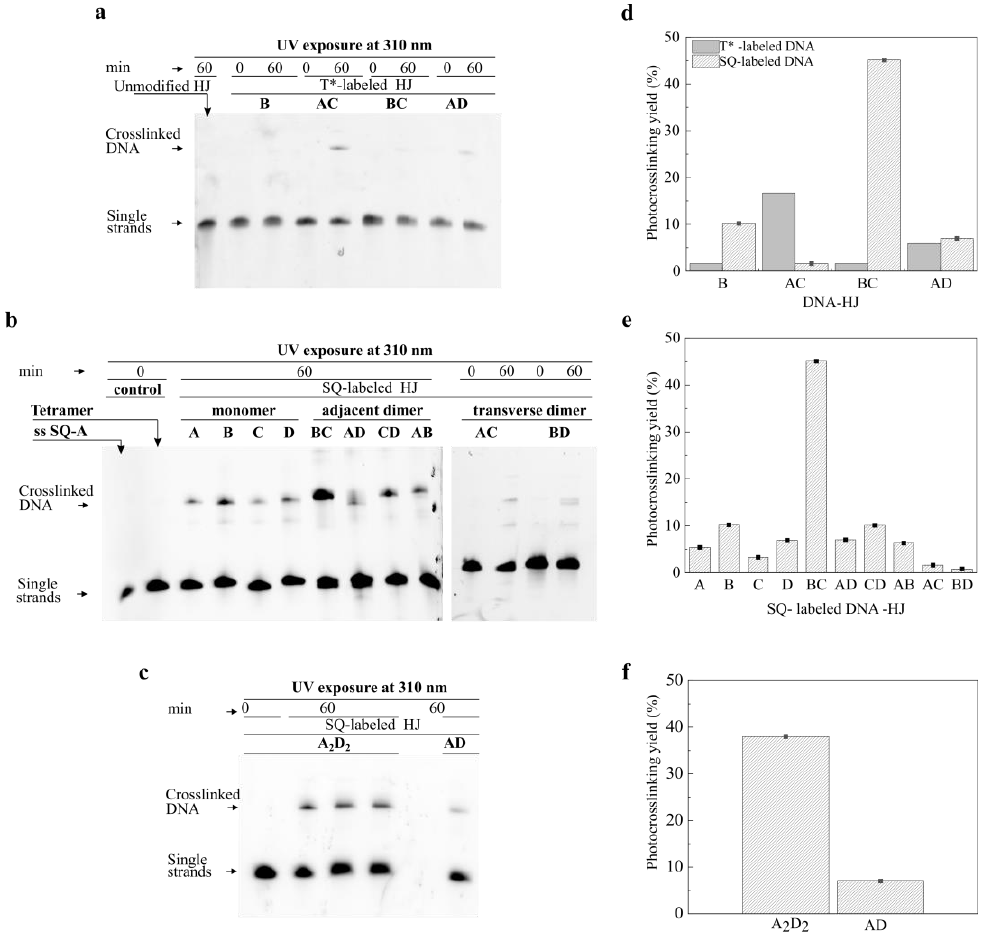
Figure 3. Electrophoretic analysis of photocrosslinking in HJ constructs. ( a – c ) Images of denaturing PAGE with samples of HJ constructs tested for photocrosslinking. The electrophoresis was carried out at 57 °C in 1× TBE running buffer. ( a ) Fluorescence image ( λ ex = 475 nm, λ em = 537 nm) of SYBR Gold stained gel with the unmodified HJ and T*-labeled HJs. ( b , c ) Fluorescence image ( λ ex = 632 nm, λ em = 691 nm) of the gel with the SQ-labeled monomers, adjacent dimers and transverse dimers. Non-irradiated samples of the single stranded SQ-labeled DNA (ss SQ-A) and SQ-tetramer tethered to HJ were used as controls. The SQ-A 2 D 2 sample was applied in triplicate. ( d – f ) Photocrosslinking reaction yield (%) of HJ constructs obtained by quantification of PAGE band intensities.